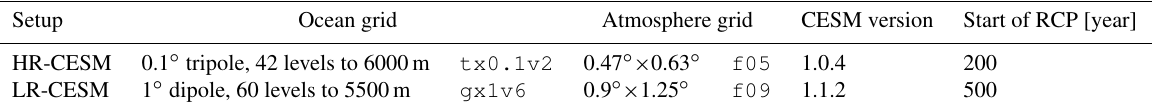
Table 1. Overview of the CESM simulations used, their ocean and atmosphere grid, and the model version, as well as the year at which the RCP simulations are branched off the CTRL